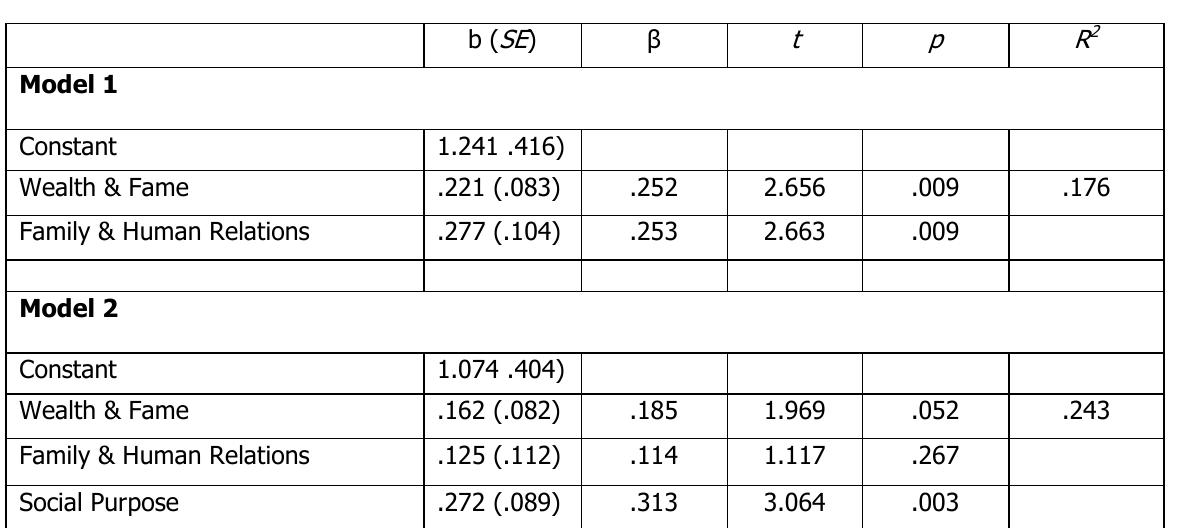
Hierarchical regression of the three life goals on achievement motivation (n = 110